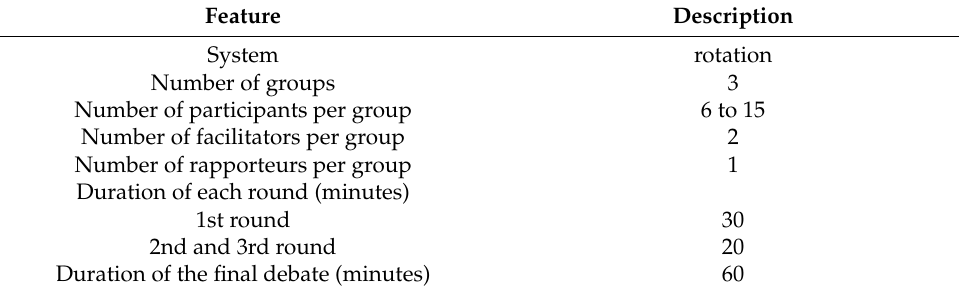
Table 3. Focus groups guidelines.